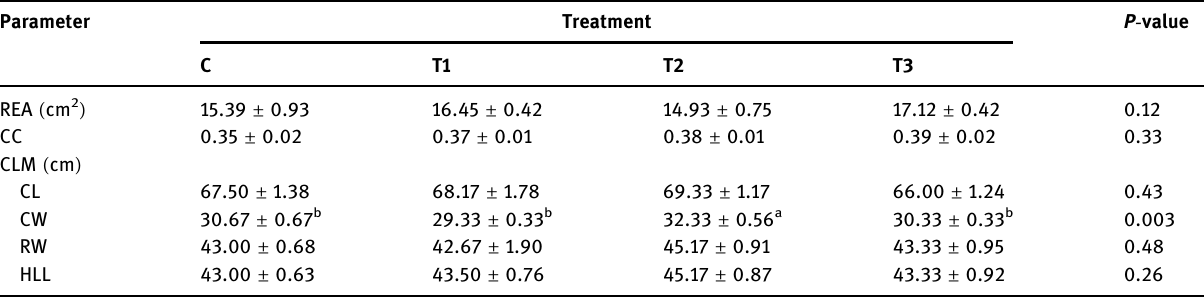
Table 10: REA, CC, and CLM of DFM - o ff ered growing Najdi lambs weaned at di ff erent ages ( mean value ± SE )